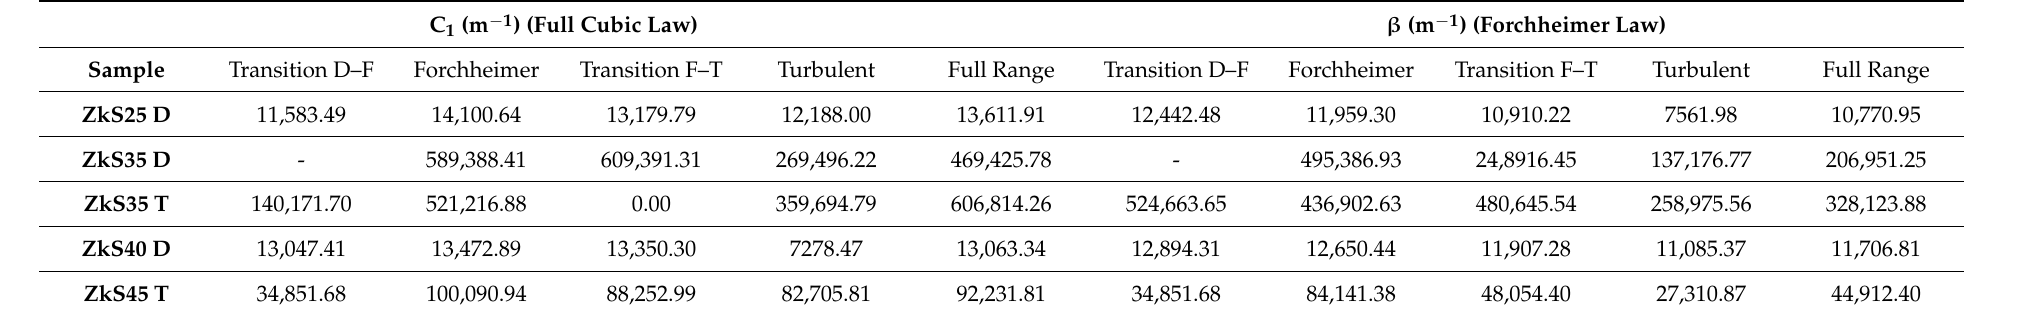
Table 4. The inertia coefficient fitted by the full cubic law and the Forchheimer equation for all regimes of air flow through ESR foams. C 1 (m − 1 ) (Full Cubic Law) β (m − 1 ) (Forchheimer